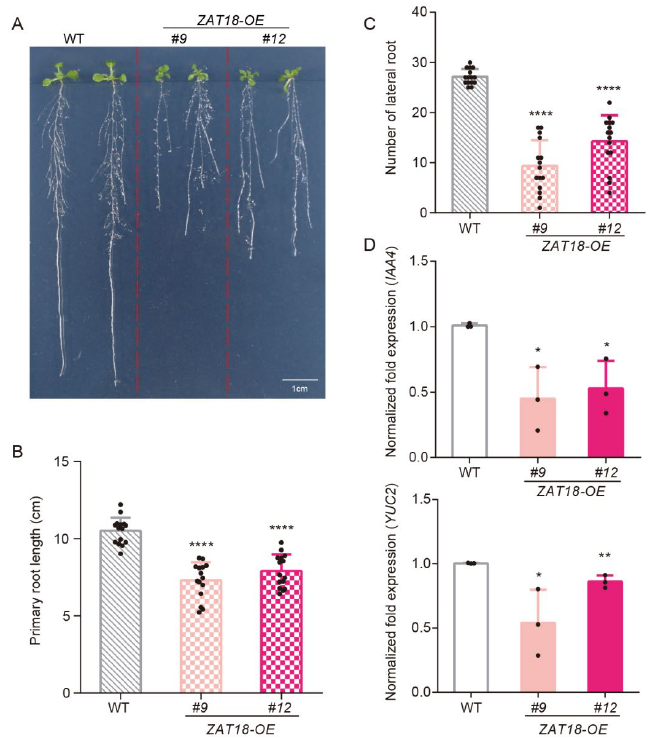
Figure 5. ZAT18 overexpression lines showed auxin-deficient phenotypes. ( A ) Representative seedlings of two-week-old WT and ZAT18-OE lines to show the growth status of their roots. ( B ) The primary root lengths of the two-week-old WT and ZAT18-OE lines were measured using ImageJ. n = 15, n indicates the number of biological replicates. ( C ) The numbers of visible lateral roots of the two-week-old WT and ZAT18-OE lines. n = 15, n indicates the number of biological replicates. ( D ) The expression levels of IAA4 and YUC2 in the two-week-old WT and ZAT18-OE seedlings without any treatment. n = 3, n indicates the number of biological replicates. * p < 0.05; ** p < 0.01; **** p <